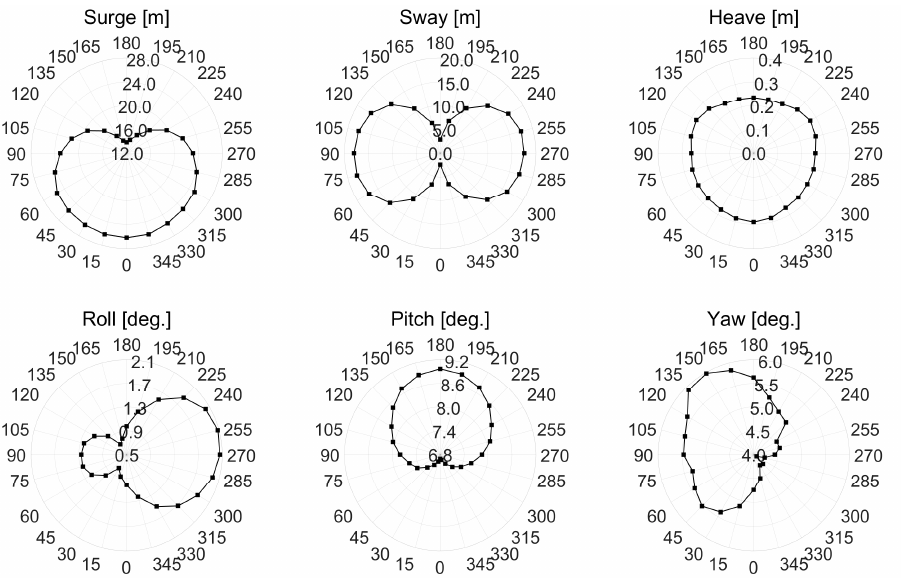
Figure 4. Absolute maximum values of the platform’s motion according to the 24 wave directions.